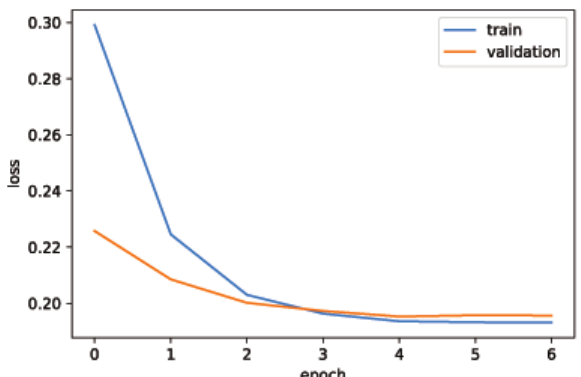
Figure 13. Learning curve representing training and validation losses of the LSTM RNN model for traffic flow